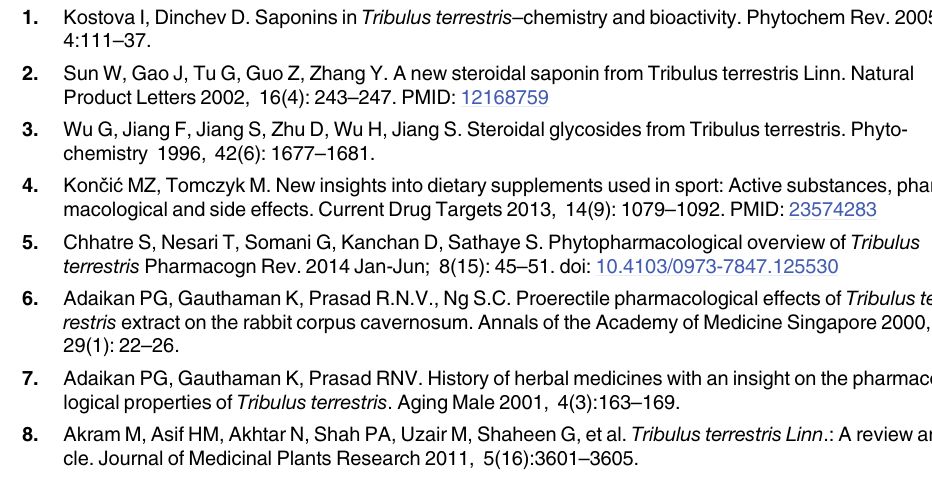
S2 Table. Density of different class follicles in the ovaries of control and experimental rab- bits. Serial 5- μ m sections in 25 μ m depth of each ovary were analyzed. Data are presented as mean ±SEM, t -test was applied, and the differences were considered significant at p < 0.05. (DOCX) S1 Fig. Kaplan-Meier analysis of the F1 offspring survivability born to control and to mothers ’ groups treated with VHT. The experimental group of mothers was treated with the feed additive VemoHerb-T (dry extract of plant the Tribulus terrestris , producer Vemo-Ltd) 45 days prior to insemination. Both groups were mated with the same male rabbit. A significantly higher survivability of F1 offspring born to experimental mothers was observed.